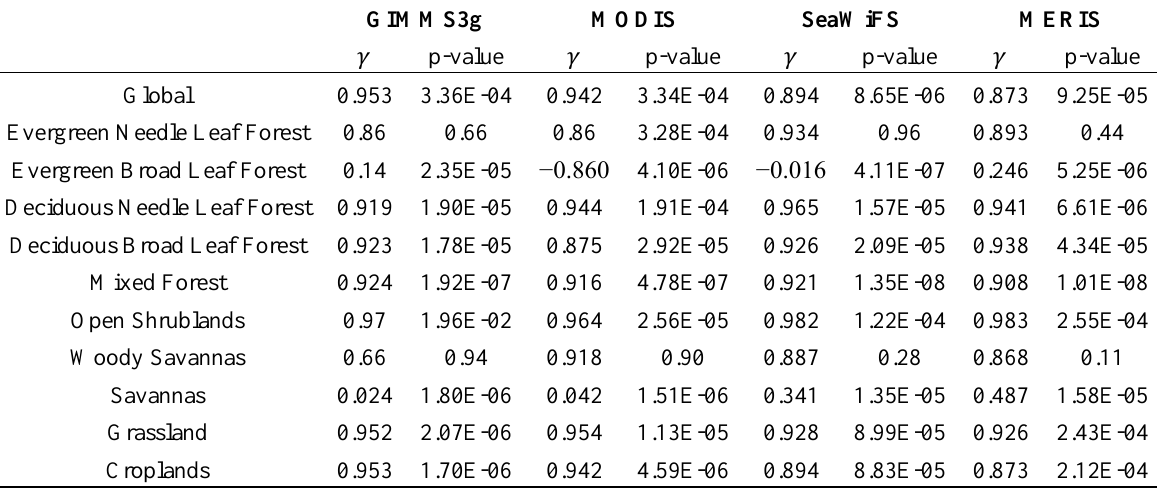
Table 1. Correlation coefficient γ with P-value between CLM4-FPAR and satellite-observed FPAR annual cycle from 2003 to